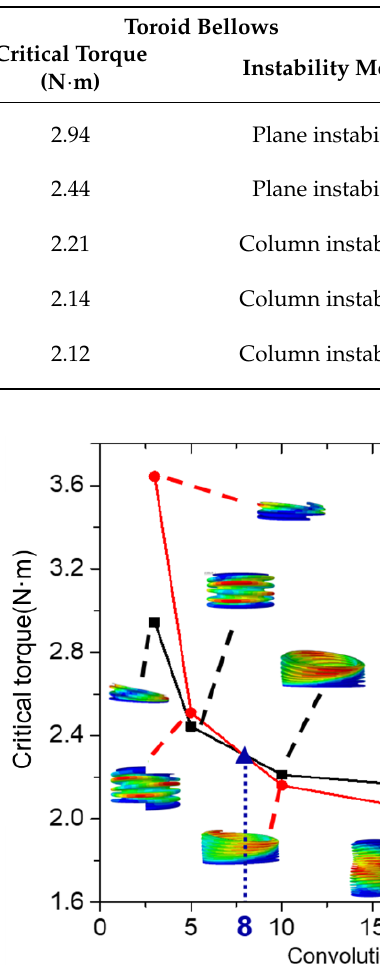
Table 2. Critical torque values and instability modes of bellows with different convolution numbers.